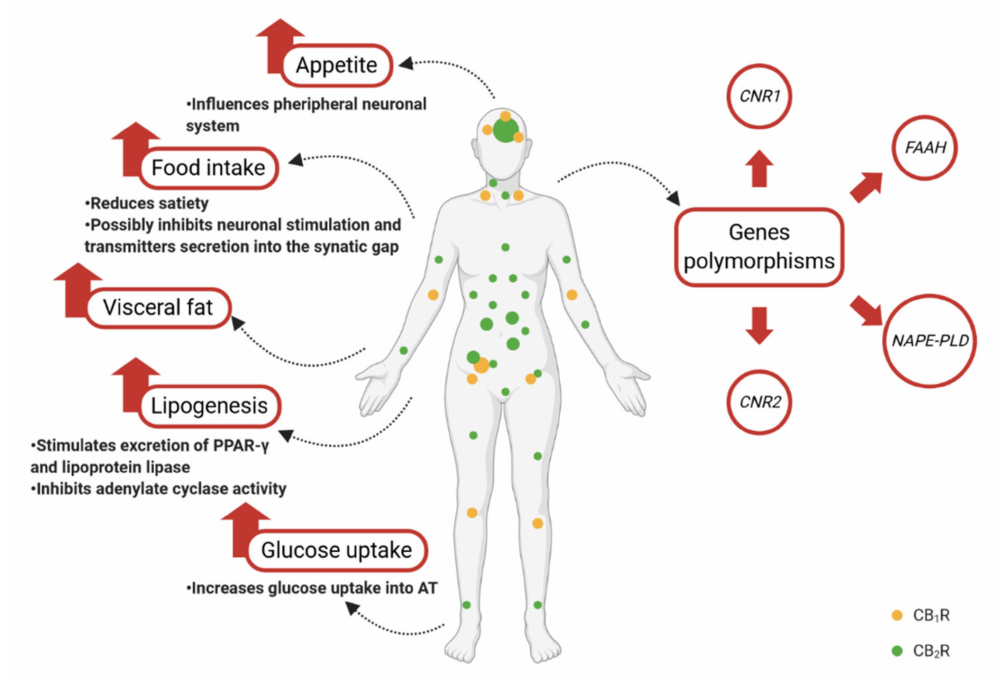
Figure 2. Schematic illustration of the endocannabinoid system role in the regulation of metabolic processes. CB1R— cannabinoid receptor type 1; CB2R—cannabinoid receptor type 2; CNR1—endocannabinoid type 1 receptor gene; CNR2— endocannabinoid type 2 receptor gene; FAAH—fatty acid amide hydrolase; NAPE-PLD— N -acyl phosphatidylethanolamine phospholipase